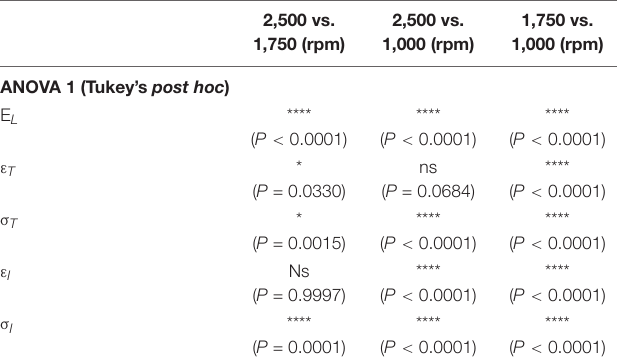
TABLE 1 | Statistical significance of differences between the sample categories in terms of linear region modulus, transition strain, transition stress, inflection strain, and inflection